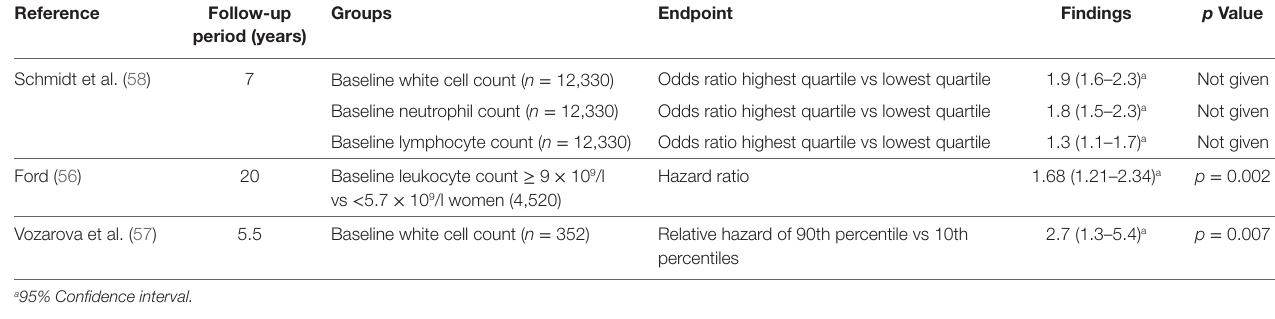
TABLe 4 | Longitudinal studies of the white cell count in type 2 diabetes.